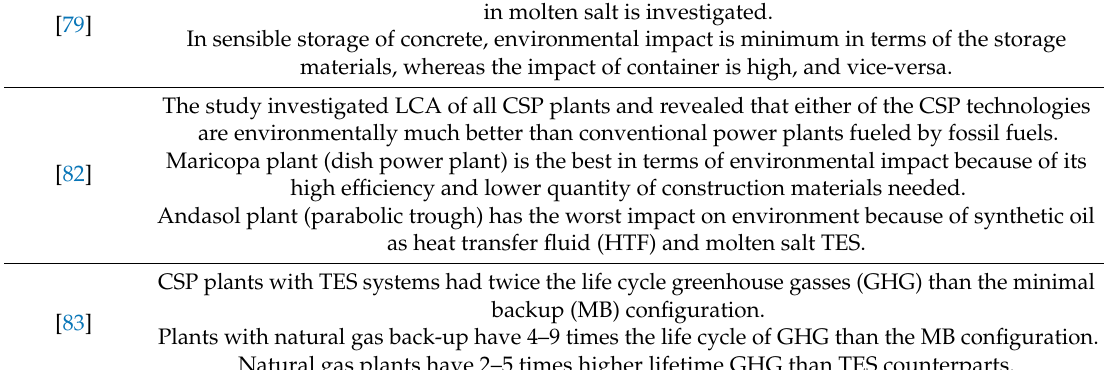
Figure 5. Influence of storage materials and container-embodied energy for the three systems [79]. Table 5. Summary of the CSP and TES life cycle assessment studies in CSP technologies.